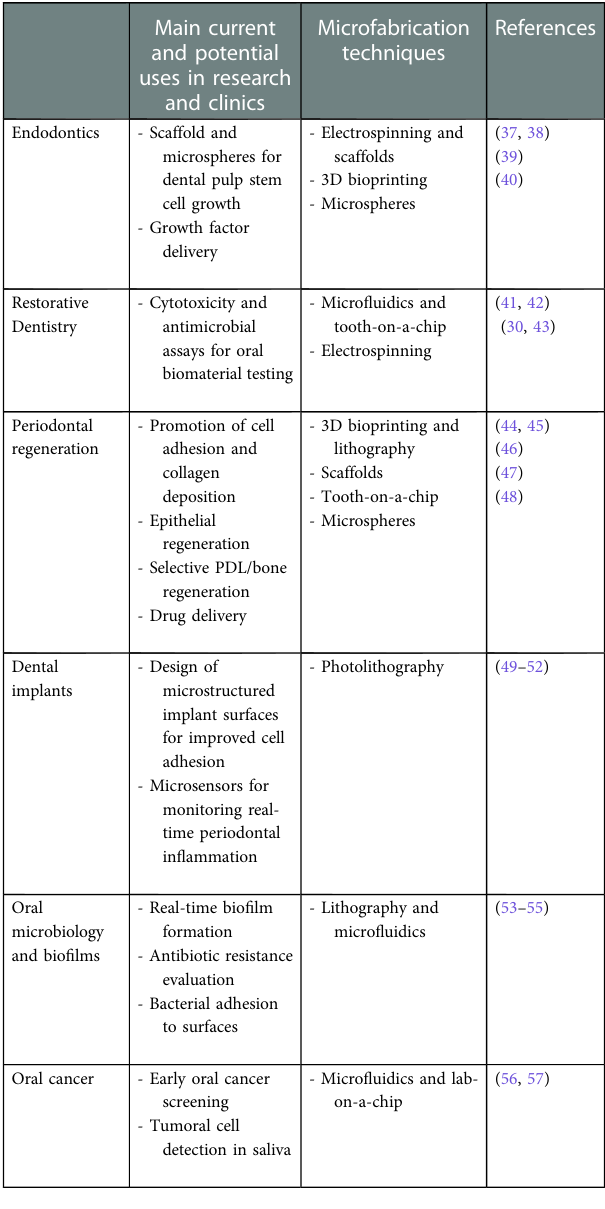
TABLE 2 Main microfabrication approaches in oral and dental